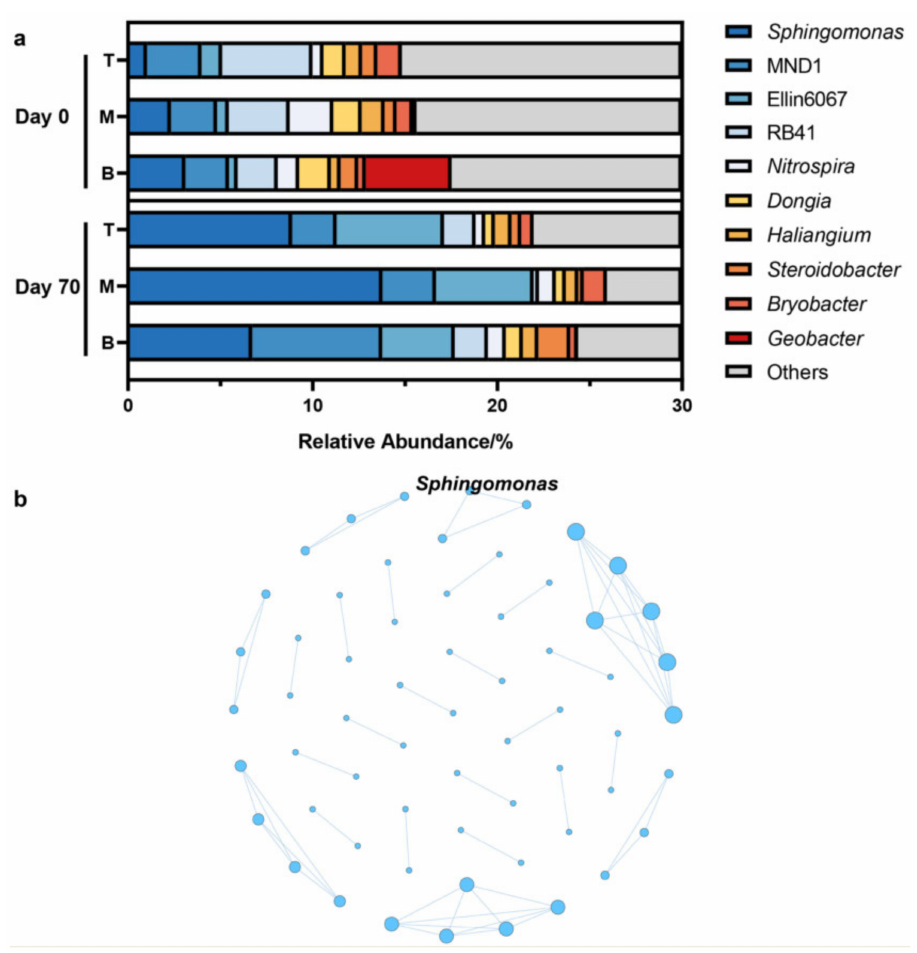
Figure 2. Relative abundance of the top-10 genera in the coking site (T: 0–10 cm; M: 10–30 cm; B: 30–100 cm) ( a ) and genus-level molecular ecology network ( b